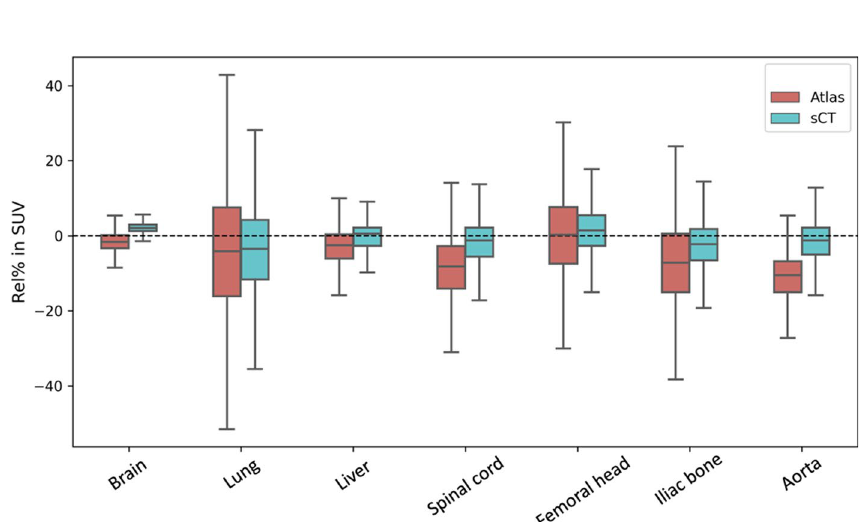
Fig. 4 Percentage difference in PET SUV mean of regions averaged across all patients for PET Atlas (red) and PET sCT (blue) compared with PET